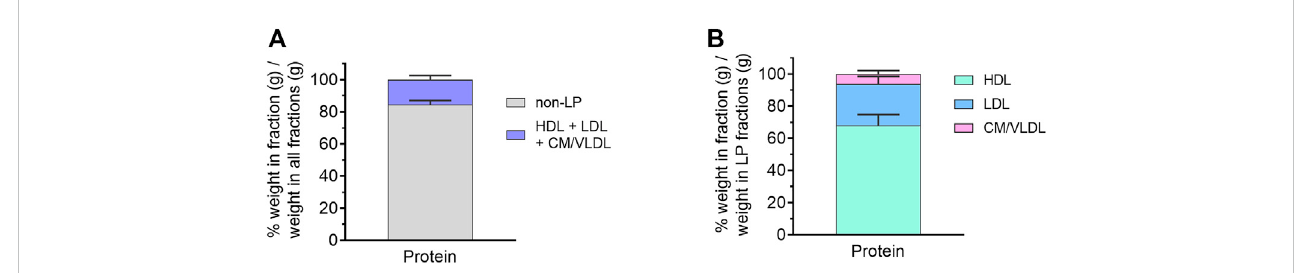
FIGURE 3 Protein content in isolated lipoprotein (LP) fractions of cervical lymph from anaesthetized, non-fasted rats. (A) Distribution of protein in different LP and non-LP fractions. (B) Distribution of LP-associated protein in different LP fractions. The protein content in each LP fraction is expressed as % weight in LP (g)/ weight in all fractions (g). Data presented as mean ± SEM (n = 3). CM = chylomicron; VLDL = very low-density lipoprotein; LDL = low-density lipoprotein; HDL = high-density lipoprotein.